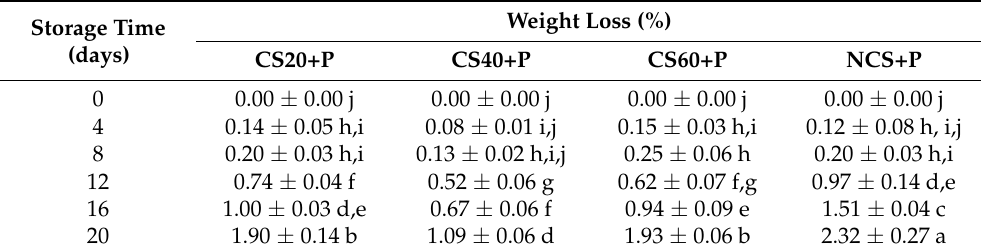
Table 1. Effect of different treatments on weight loss of cucumbers during storage at 13 ± 2 ◦ C. CS20+P—packaged after 20 min of cold shock; CS40+P—packaged after 40 min of cold